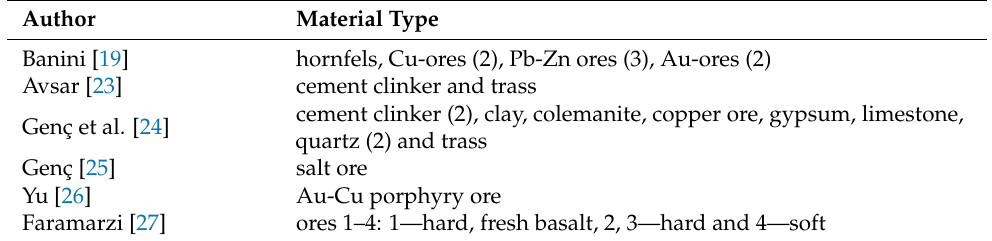
Table 2. Material types and sources of sieving data for